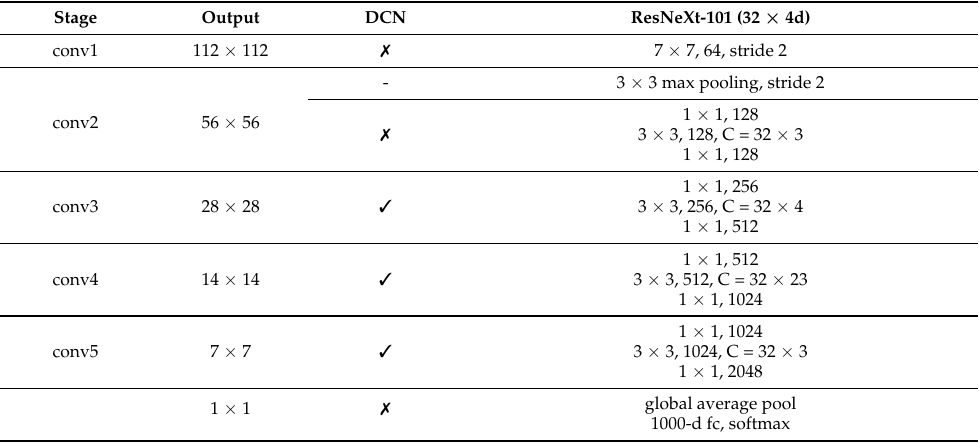
Table 1. Architectural details of the employed dual composite ResNeXt-101 backbone network. DCN represents the incorporation of deformable